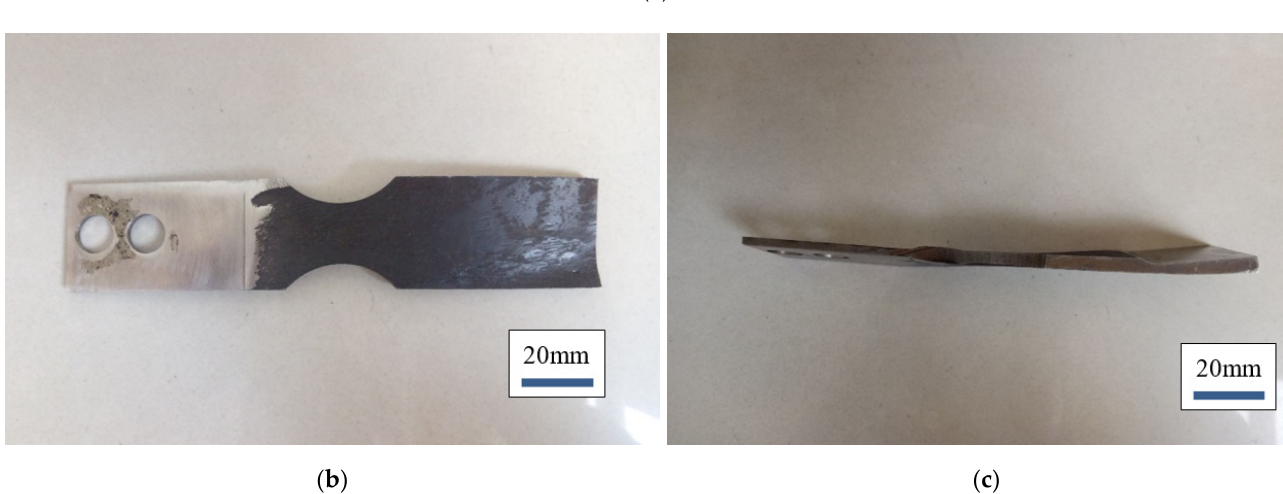
Figure 3. Impeller and KMN blade specimen. ( a ) Impeller; ( b ) KMN blade specimen after service; ( c ) top view of blade specimen.